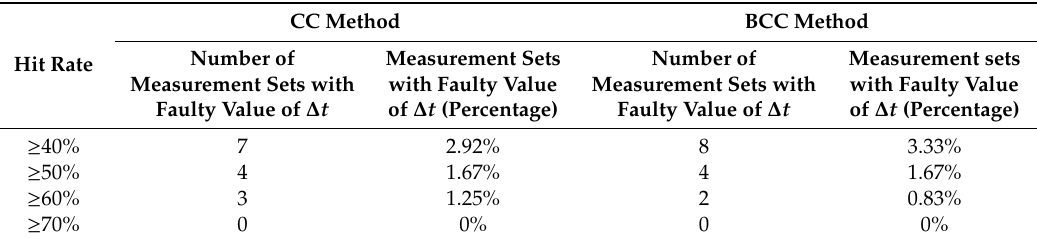
Table 11. Measurement sets with significant error for di ff erent hit